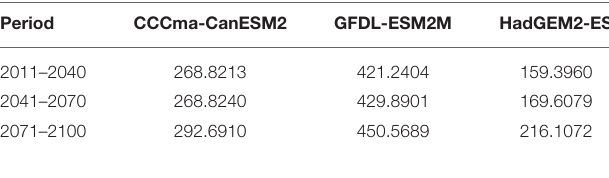
between 2011 and 2100.